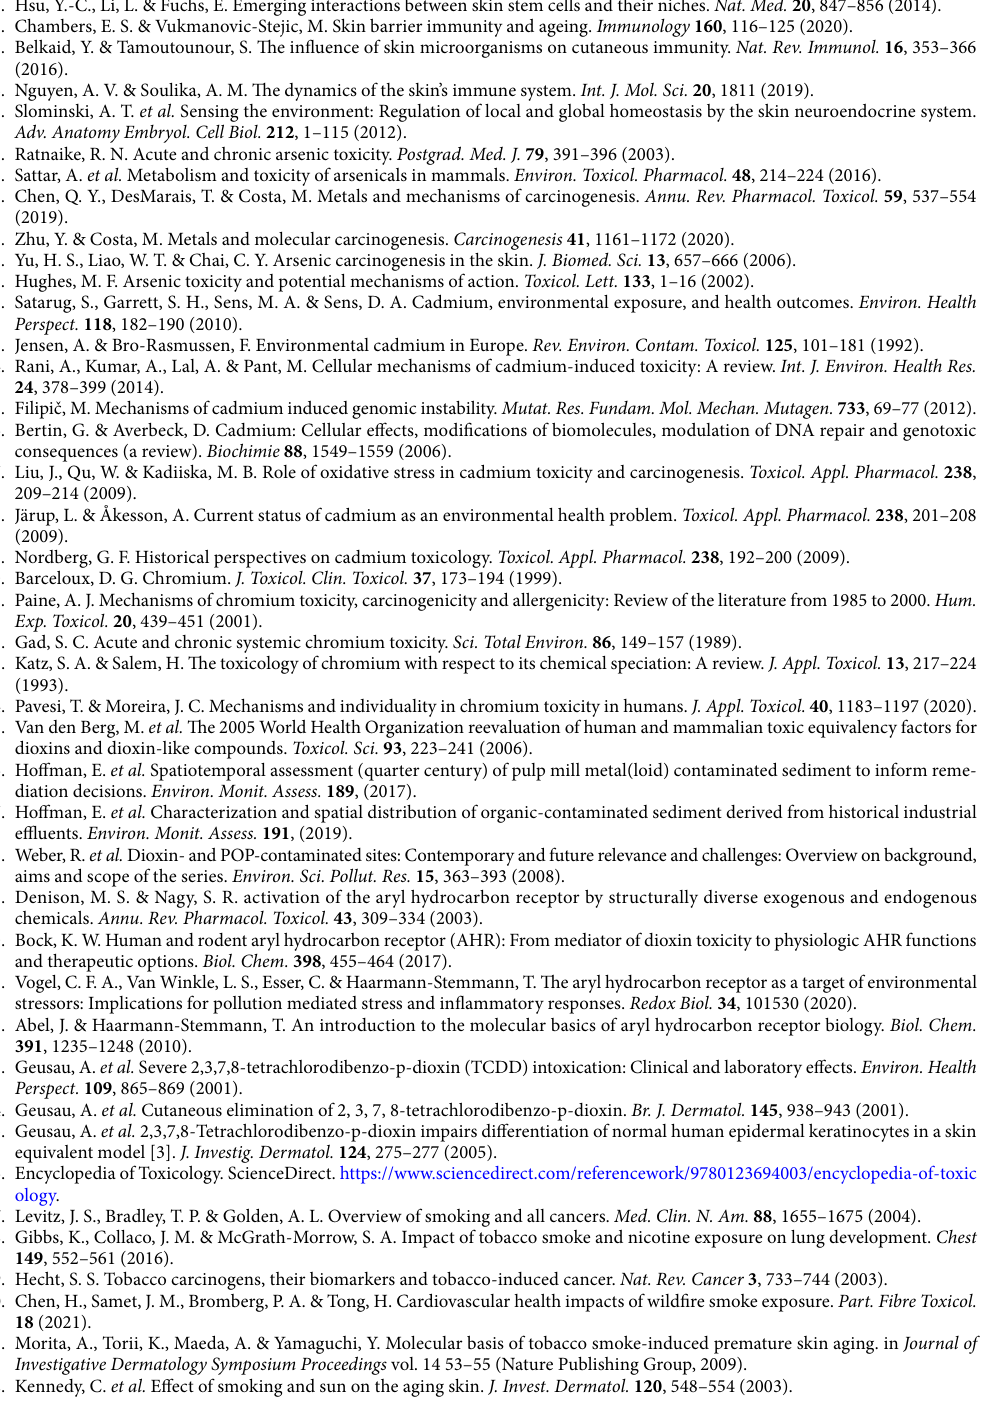
For statistical analyses of gene expression data, an unpaired t-test was applied, setting p ≤ 0.05 and fold change ≥ 2.0 as limits for significance. qRT-PCR data were analysed by a comparative C T method, using 18S rRNA expression as internal control. Gene expression fold changes were represented as the ratio between means of 2 -ΔCt values in ambient pollutant exposed SOC samples with respect to control